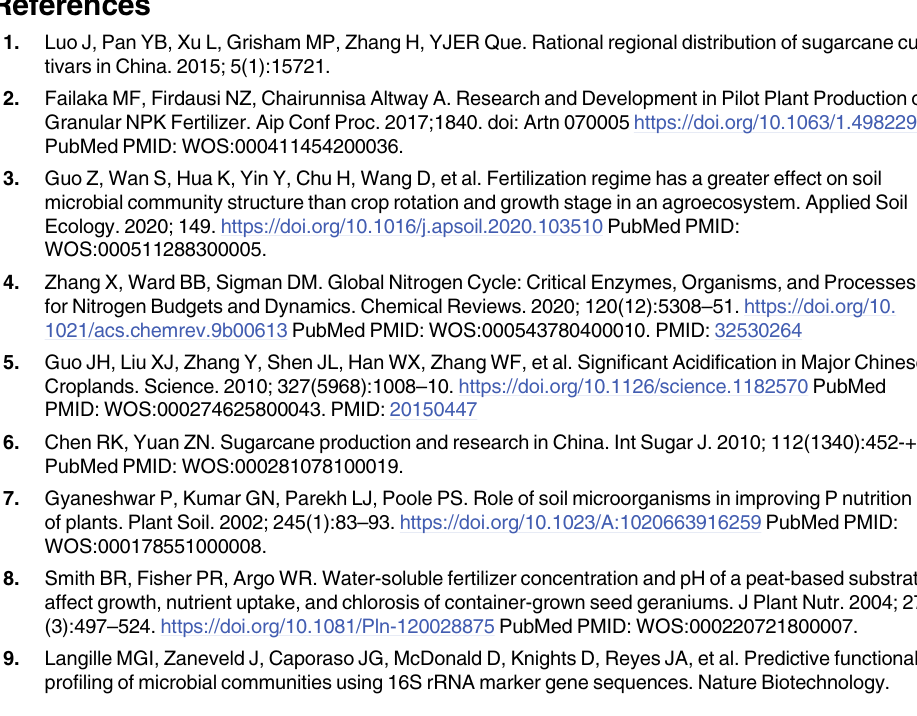
S1 Fig. Rarefaction curves at an OTU threshold of 97% sequence similarity (a, b) for soil sam- ples taken derived from three sugarcane